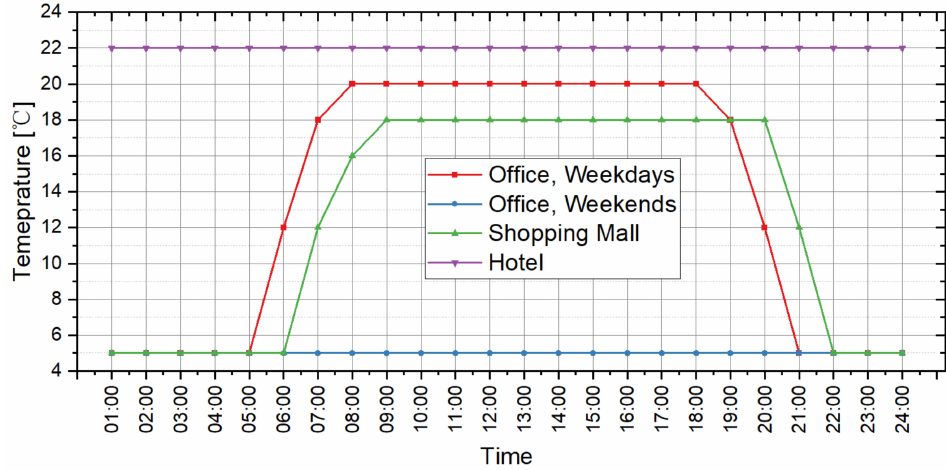
Figure 4. Indoor design temperature in